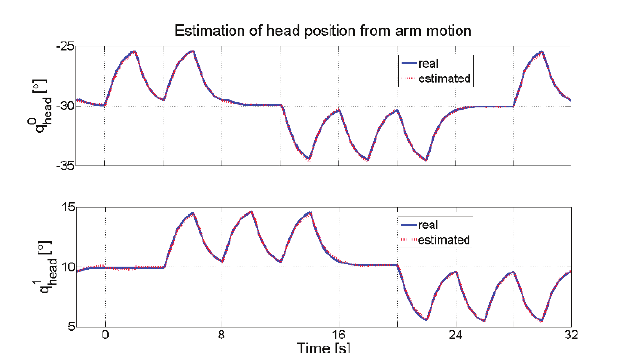
Figure 27. Comparison between real head motion, q head ( t ) blue solid line, and estimated one, ˆ q head ( t ) red dashed line, during the execution of the arm-head coordination test without the